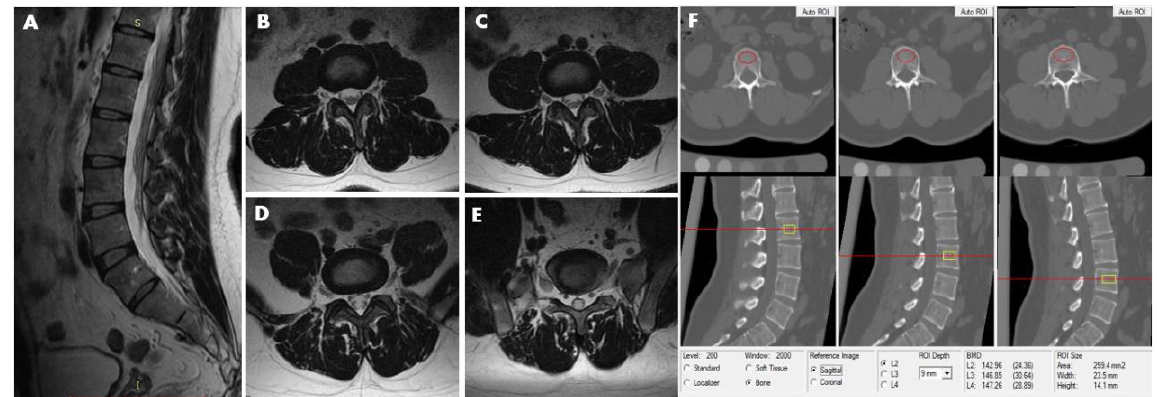
Figure 1. This 40-year-old male participant was assigned to the non-LDH group. MRI (T2-weighted image) revealed no lumbar disc herniation from L2 – 3 to L5 – S1disc. ( A ) Sagittal image. ( B ) L2/3 axial image. ( C ) L3/4 axial image. ( D ) L4/5 axial image. ( E ) L5/S1 axial image. ( F ) The measurements of L2, L3, and L4 vertebral trabecular volumetric bone mineral density (Trab.vBMD) are shown; the BMD of L2, L3, and L4 is 142.96 mg/cm 3 , 146.85 mg/cm 3 and 147.26 mg/cm 3 , respectively. The average lumbar Trab.vBMD is 145.69 mg/cm 3 .